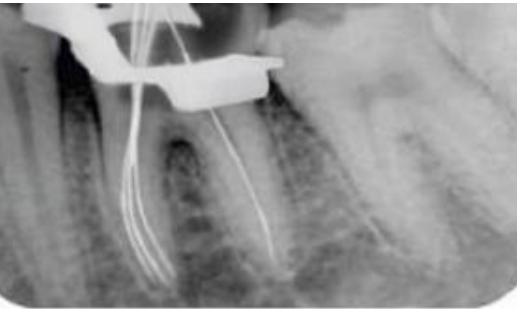
Figure 4: Working length radiograph. After confirmation of four canals, pulpectomy was performed.